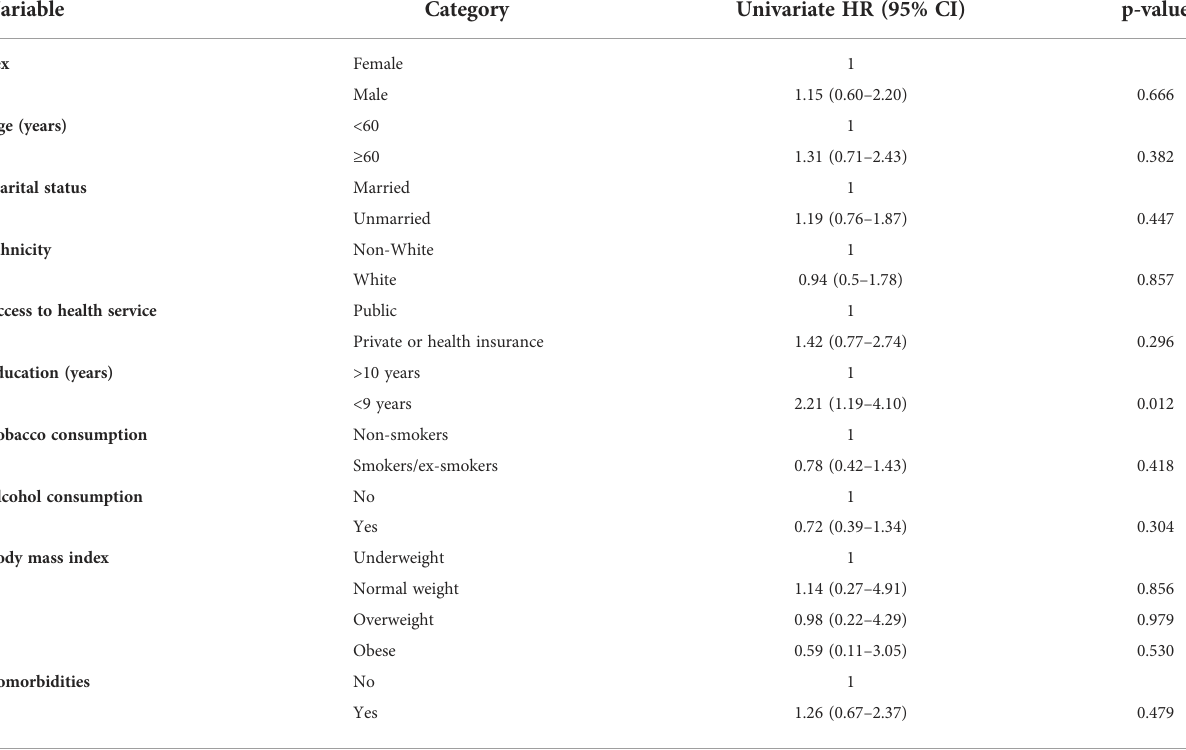
TABLE 3 Cox univariate regression analyses of 1-year overall survival prognostic factors of 41 patients with gastric adenocarcinoma.